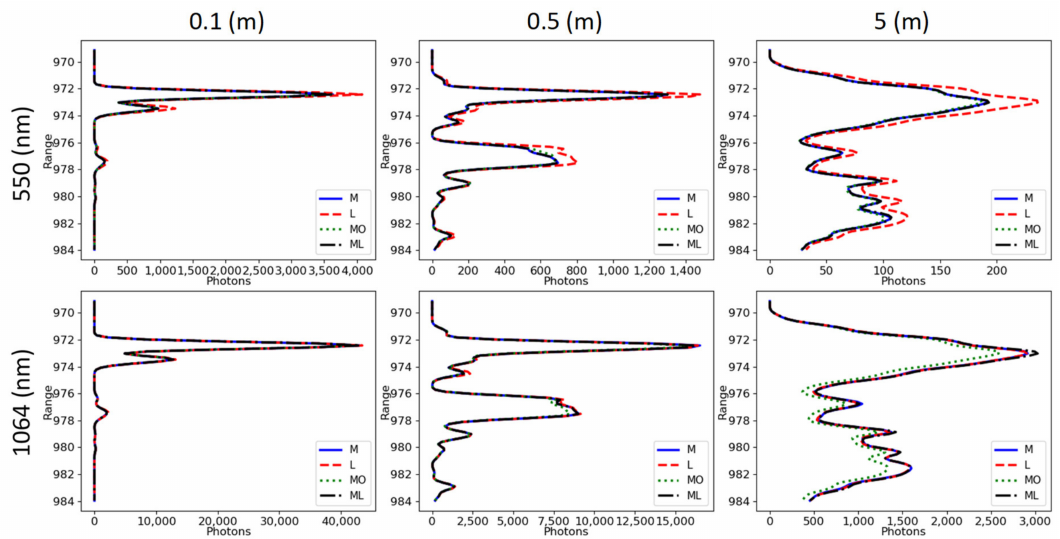
Figure 17. Waveform comparison plots for the maple and oak grove scene for each leaf BSDF type. Plots are shown for the three beam footprint diameters of 0.1, 0.5, and 5 m (left-to-right) and the two wavelengths of 550 and 1064 nm (top-to-bottom). The legend symbols for the four leaf BSDF types are “M” for model, “L” for Lambertian, “MO” for model reflectance and no transmittance, and “ML” for model reflectance and Lambertian transmittance. Only the main canopy range is shown, thereby highlighting any di ff erences.